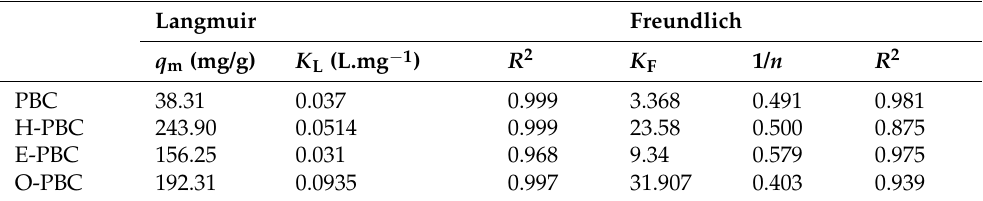
E-PBC, and O-PBC.